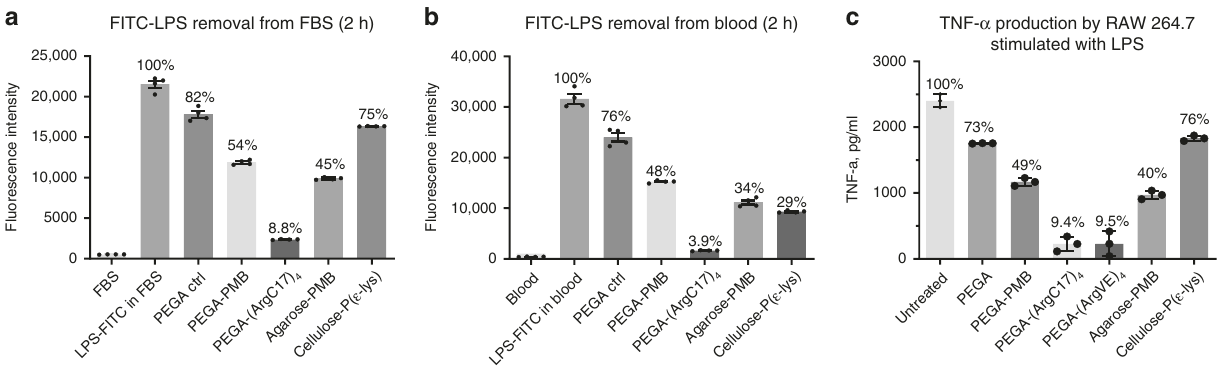
Fig. 3 LPS attenuation by TD NT resins. The removal of FITC-LPS (12.5 µ g/mL) by nanotrap PEGA hydrogel resins in comparison with commercial LPS- removal resins ( a ) in FBS and in ( b ) whole blood after 2-h incubation, respectively. c The stock LPS solution was pretreated with or without different LPS- adsorption resins before adding to RAW 264.7 cells at an untreated LPS concentration of 500 ng per mL. TNF- α production in the culture medium after overnight incubation was analyzed by ELISA assay ( n = 4, mean ± SEM). Source data are available in the Source Data fi